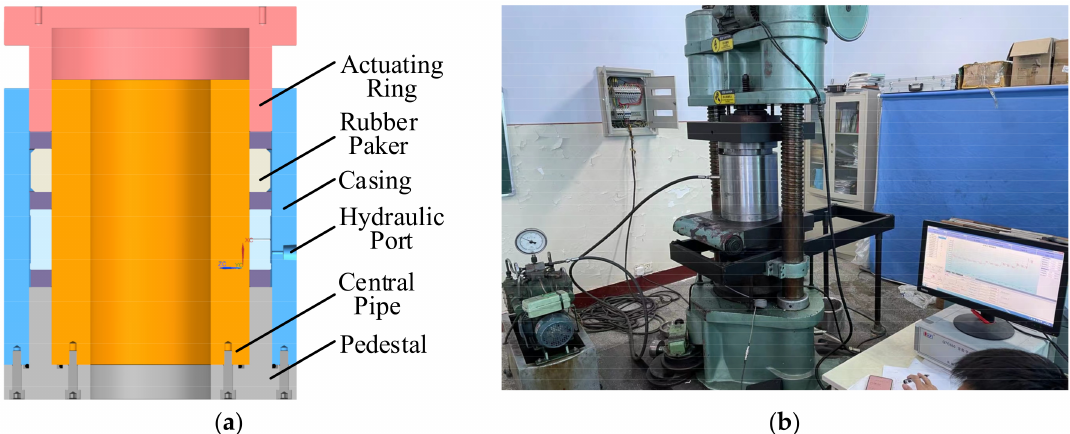
Figure 12. Diagram of test device. ( a ) 3D model; ( b ) Test